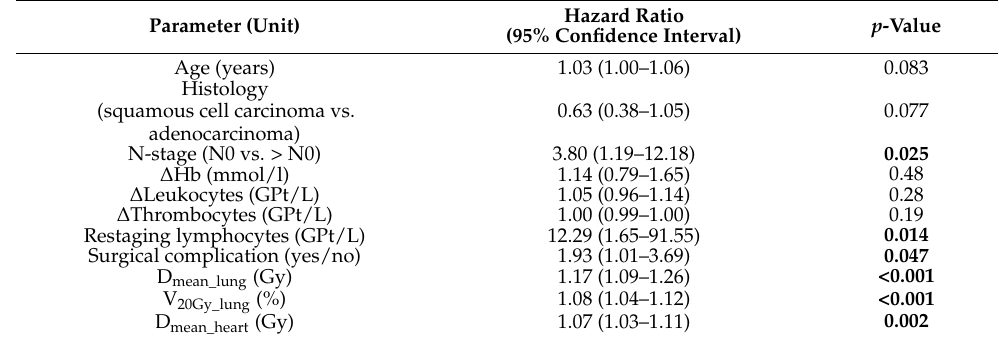
Table 3. Univariate Cox regression for overall survival ( n = 125). The significant p -values are printed in